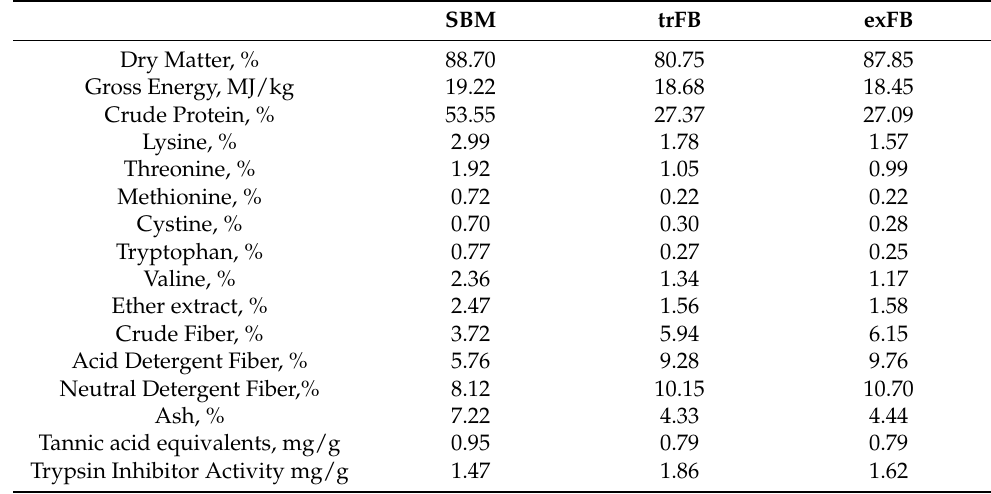
Table 1. Chemical composition of soybean meal (SBM), raw field beans treated with propionic acid (trFB) and field beans treated with propionic acid and extruded (exFB) 1 ( n =